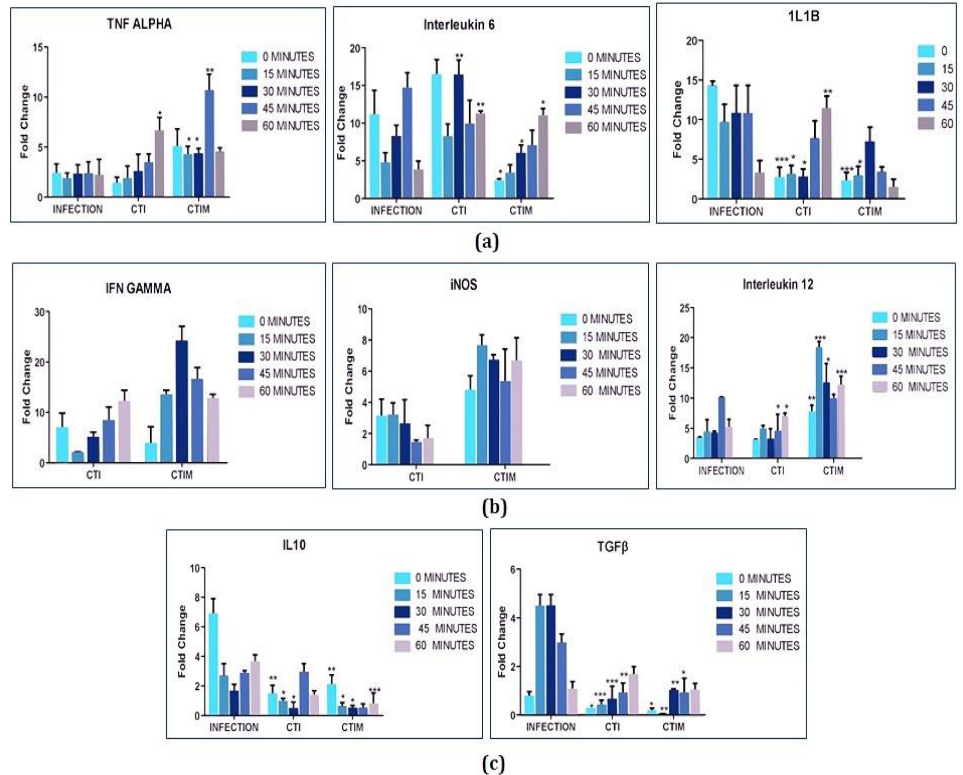
Figure 8. Cytokine profiling of synthetic circuit: Macrophages were first transfected with synthetic circuit using, Polyethylenimine (3:1 ratio PEI: DNA) and then induced with 1mM IPTG for 48 h followed by infection with stationary phase promastigotes in 1:10 macrophage to parasite ratio for 24 h. Un-internalized parasites were washed off and samples were collected at different time points. ( a ) Cytokines released during initial interaction. ( b ) Cytokines associated with M1 phenotype. The levels of IFNγ and iNOS have not been observed in the Infection group therefore, bars are not shown. ( c ) Cytokines associated with M2 phenotype. C: Control, I: Infection with L. major , EV: Transfection of Cells with empty vector. CTI: Transfection of cell with synthetic circuit and then infection. CTIM: Transfection of cell with synthetic circuit and then infection followed by Miltefosine treatment. The experiments were performed thrice. The error bars represents mean ± SD with p value * p < 0.05, ** p < 0.01, *** p < 0.001.